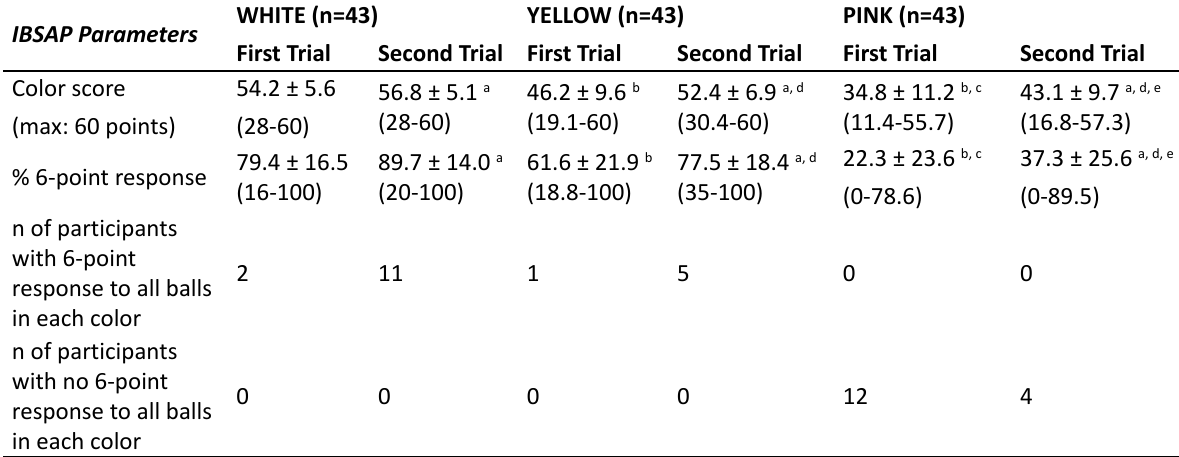
Table 4. Results obtained in first and second trials for each colored ball in IBSAP.